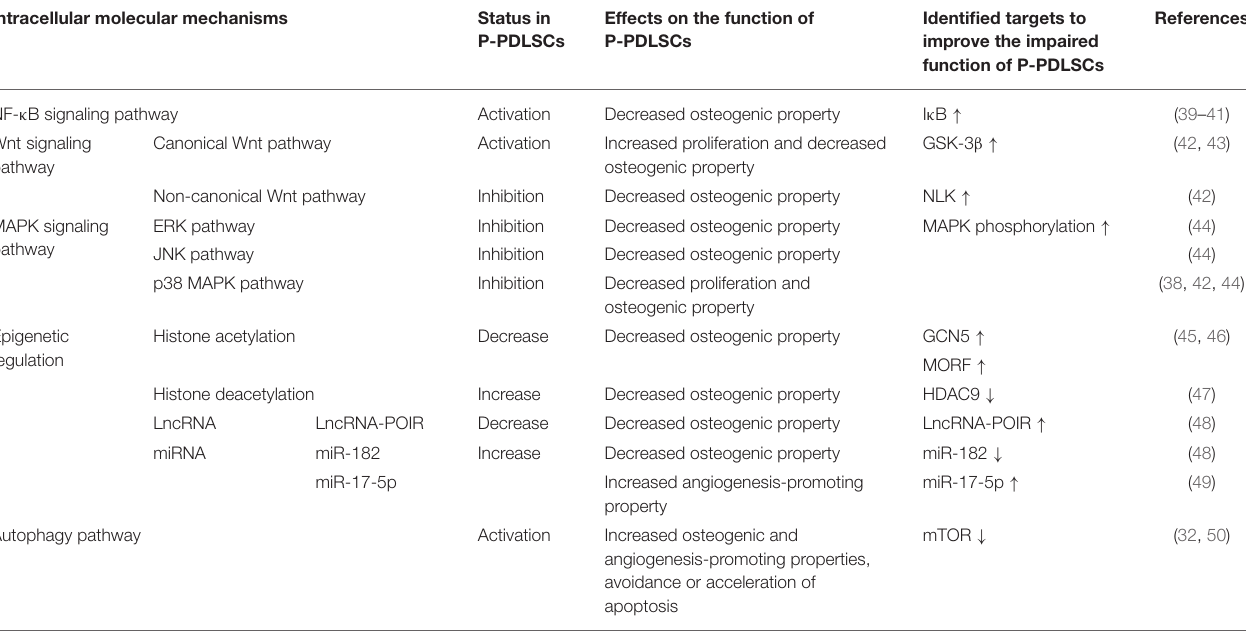
TABLE 1 | Known molecular mechanisms underlying P-PDLSC dysfunction and targeted therapies to improve the impaired function of